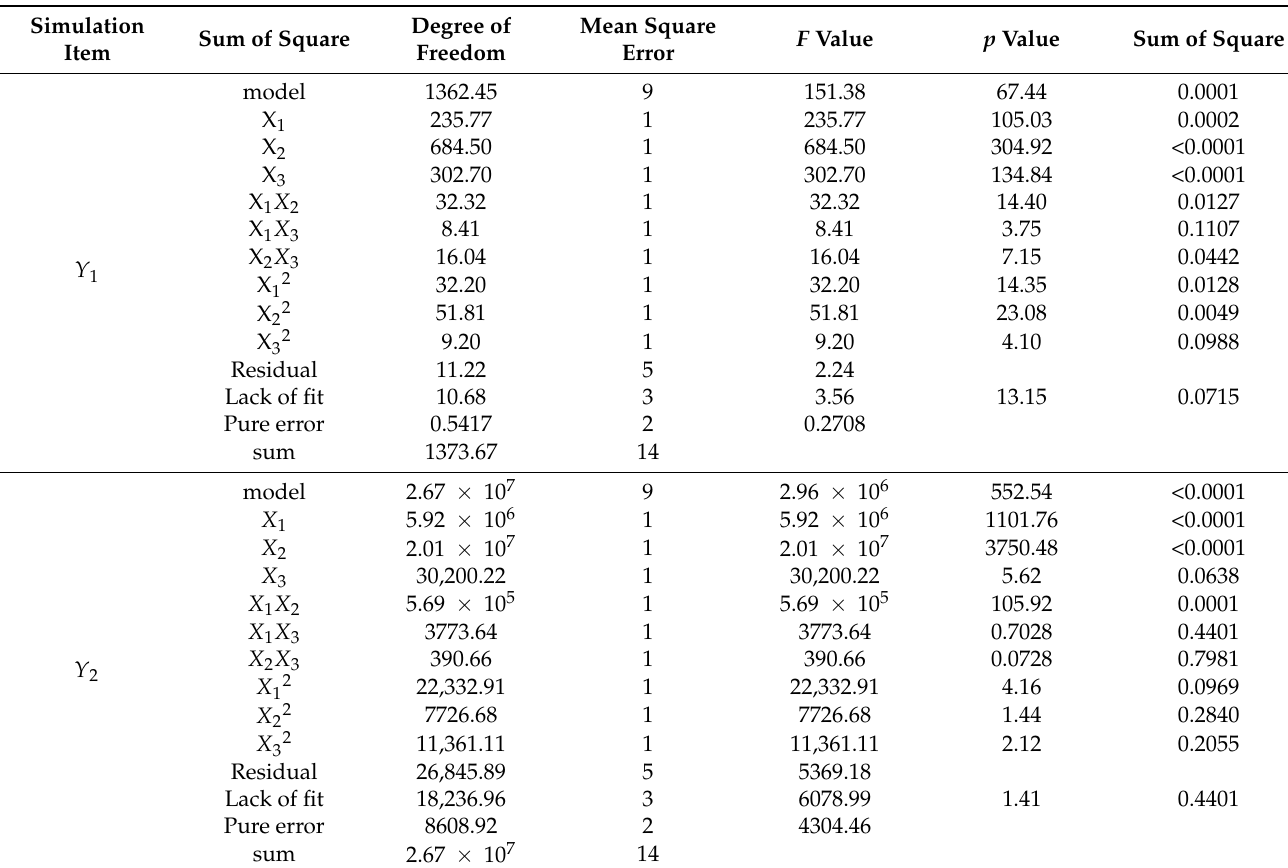
Table 3. Regression equation analysis of